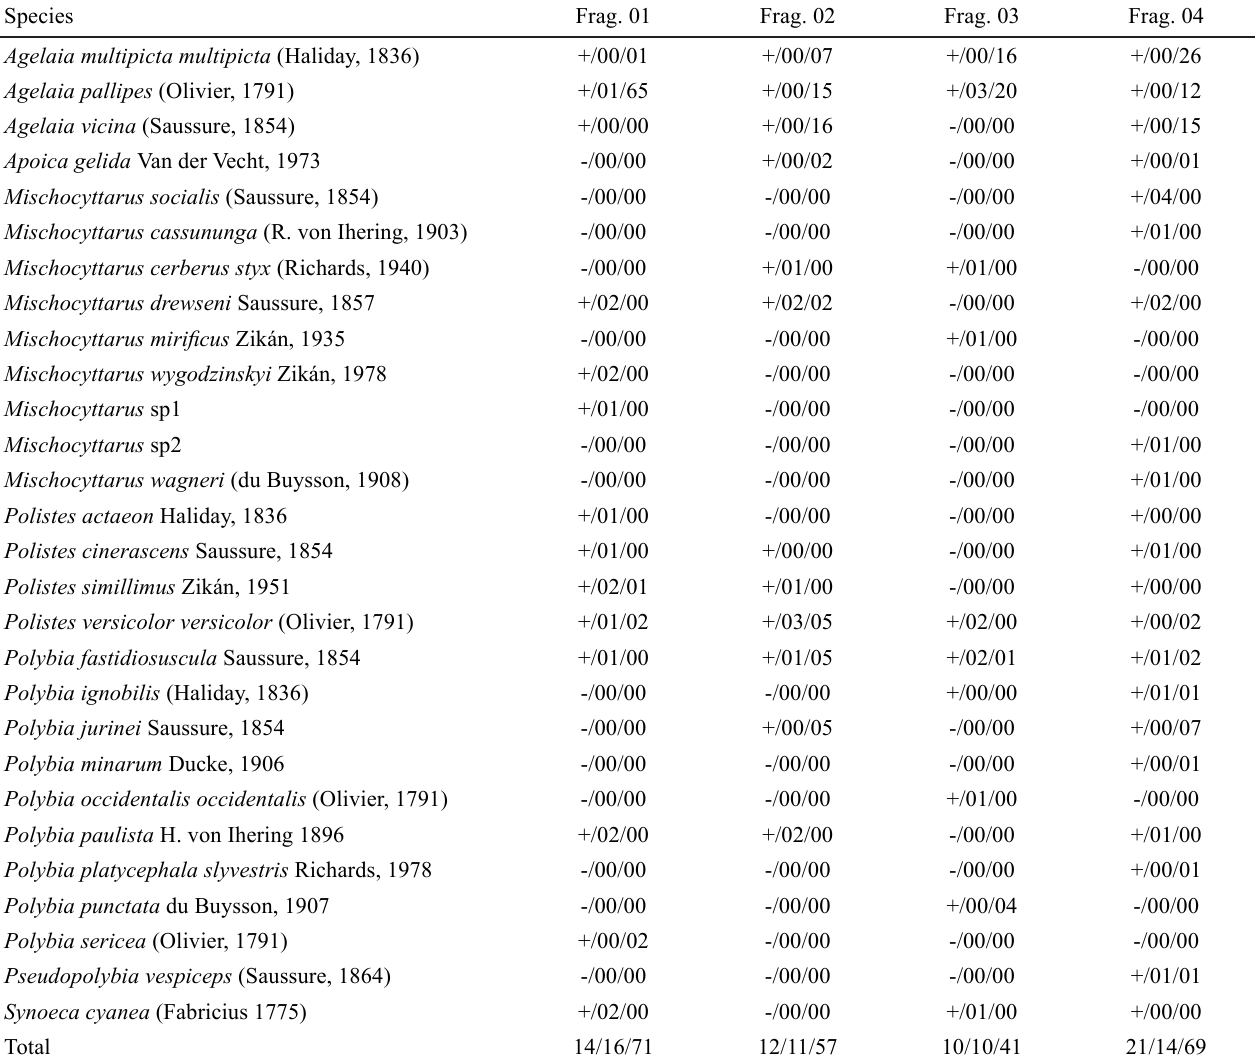
Table 2 . Species of social wasps (presence +; absence -), number of colonies and number of samples collected by species with a passionfruit attractive trap in four fragments of Montane Semideciduous Seasonal Forest (Frag.) in the municipalities of Inconfidentes and Ouro Fino, in the south of the state of Minas Gerais in the Souutheast region of